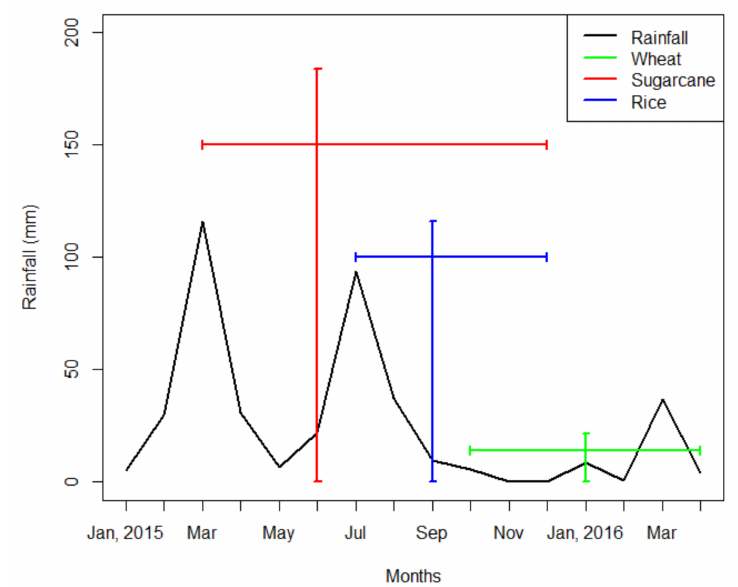
Figure 5. Effective rainfall depth and length of the growing season of each selected crop in the study